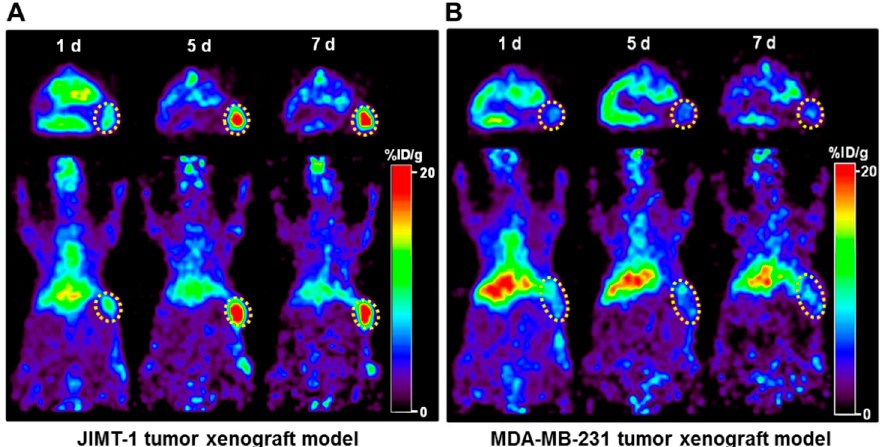
Figure 4. Immuno-PET imaging of 89 Zr-DFO-pertuzumab in HER2-positive (JIMT-1) and -negative (MDA-MB-231) breast cancer xenograft models. PET images were acquired at 1 day, 5 days, and 7 days after injection of 89 Zr-DFO-pertuzumab in ( A ) HER2-positive (JIMT-1) and ( B ) -negative (MDA-MB-231) tumors. Tumors are indicated as yellow dotted circles. The tumor uptake of 89 Zr-DFO-pertuzumab was similar to that of the liver on day 1, but JIMT-1 tumor uptake increased, and liver uptake decreased in a time-dependent manner. At the same time, the uptake in the MDA-MB-231 tumor was relatively lower than that in the liver as time elapsed. All images were represented as the percentage of the injected radioactivity dose per gram of tissue (%ID/g).